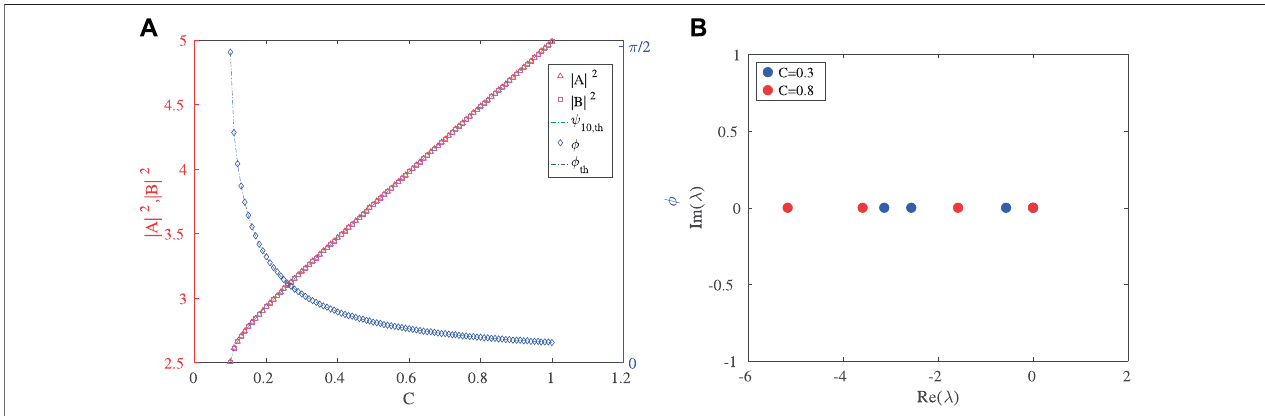
FIGURE 1 | (A) Amplitude and phase of steady state symmetric solutions from the upper symmetric branch. (B) Spectral plane (Re( λ ),Im( λ )) representation of the eigenvalues λ for C =0.3and C =0.8.Otherparameter valuesare γ =1.0, δ =0.1, g 1 =0.3, g 2 =0.4and ~ g (cid:2) 0 . 5.Intheleftpanel,theleftaxiscorrespondstoamplitudes, while the right to phases, while the subscript “ th ” corresponds to the theoretical prediction and the symbols correspond to numerical results.